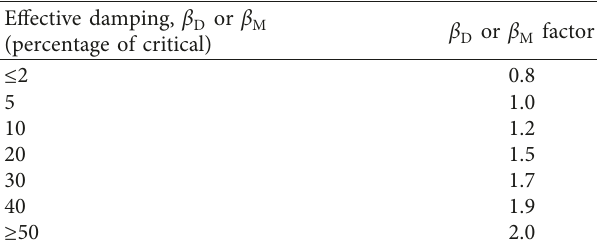
Table 5: Damping coefficient (ASCE7-10, Table